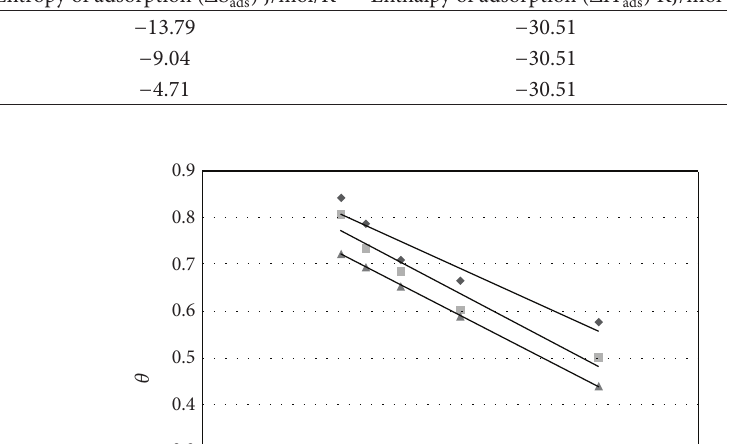
F 4: Structure of ACMU.